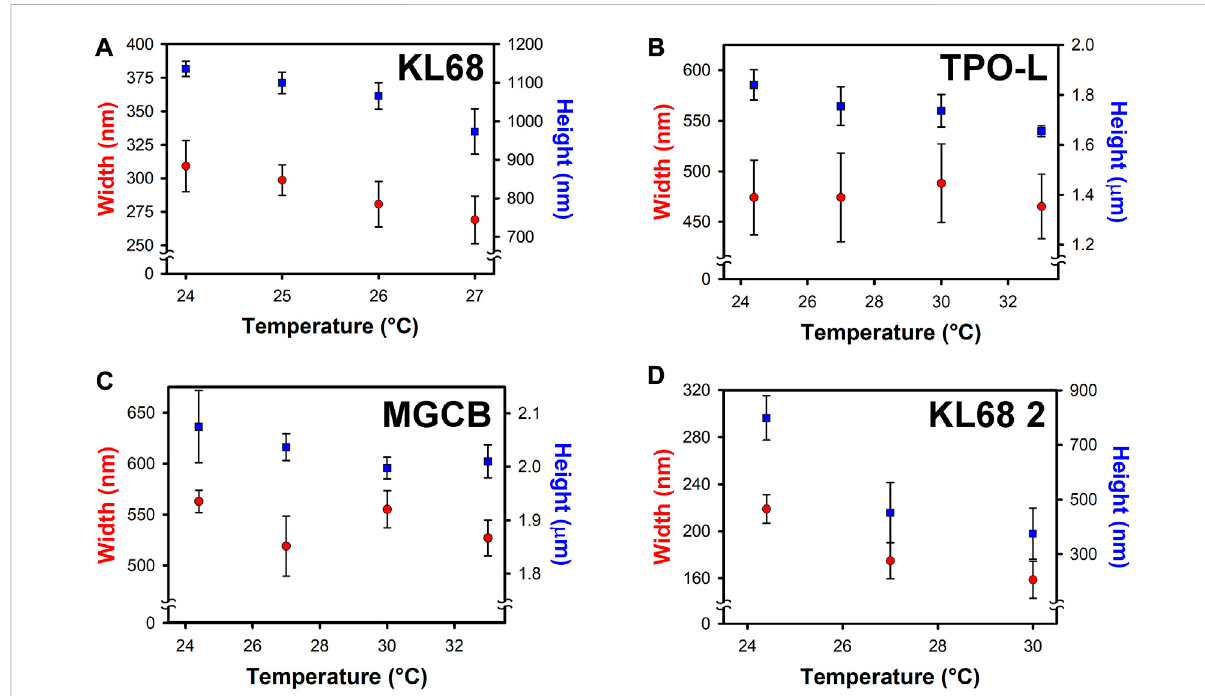
FIGURE 3 Temperaturedependenceofthevoxelheight(squares)andwidth(circles)inaphotoresistcomposedof (A) 0.05 wt%KL68in1:1SR368/499ata fi xed irradiance and exposure time. (B) Voxel size temperature dependence for 3 wt% Lucirin TPO-L in 1:1 SR368/499. (C) Voxel size